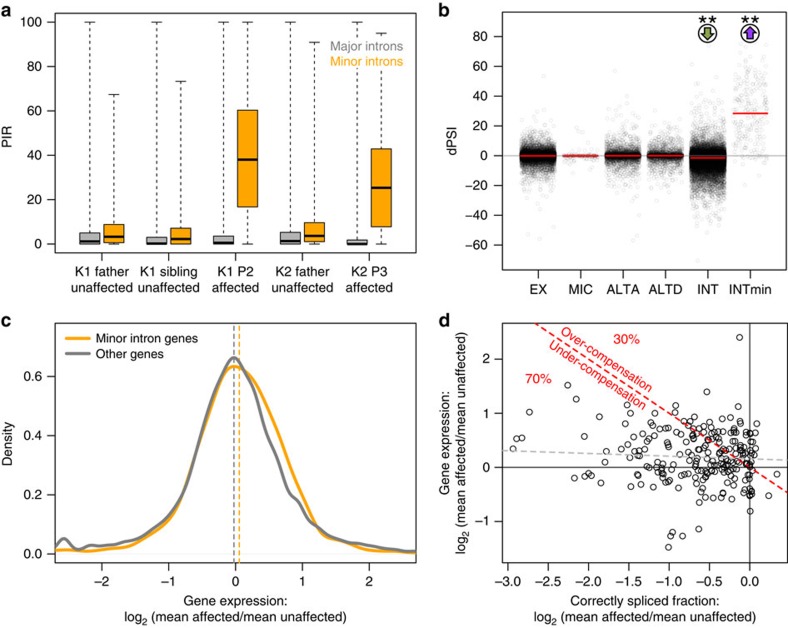
Summary of RNA-seq findings.(a) PIR for major (grey) and minor (orange) introns, for kindred 1 and kindred 2 subjects, showing specific minor intron retention in affected subjects compared with unaffected subjects. (b) Affected–unaffected average difference in percentage alternative splicing (dPSI) for different alternative splicing categories (ALTA, alternative 5′ splice site; ALTD, alternative 3′ splice site; EX, cassette exon; INT, major intron retention; INTmin: minor intron retention; MIC, micro-exon); significant deviation from 0 is observed only for major introns (small yet significant reduction in affected) and minor introns (significant increase in affected). (c) Log2 of the mean expression ratio between affected and unaffected, for minor intron genes and all other genes, displaying a slight shift of minor intron genes towards higher expression in affected subjects. (d) Scatterplot showing that increased expression in affected relative to unaffected subjects (y axis, log2 ratio of the mean expression in the two groups) is insufficient to compensate for the increased minor intron retention (x axis, log2 ratio of the mean correctly spliced fraction in the two groups), with 30% of the genes over-compensated and 70% of the genes under-compensated (separated by the red dashed line); the linear correlation between the expression ratio and correctly spliced ratio is negative but modest (grey dashed line).